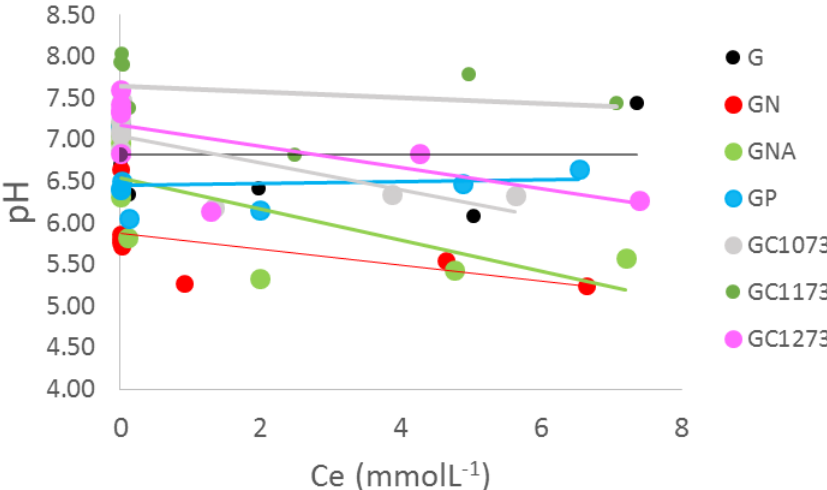
Figure 5. pH values for the phenol adsorption process during the two hours of the calorimetric determination. The lines correspond to the tendency of the dates. Table 3. Chemical parameters of the activated